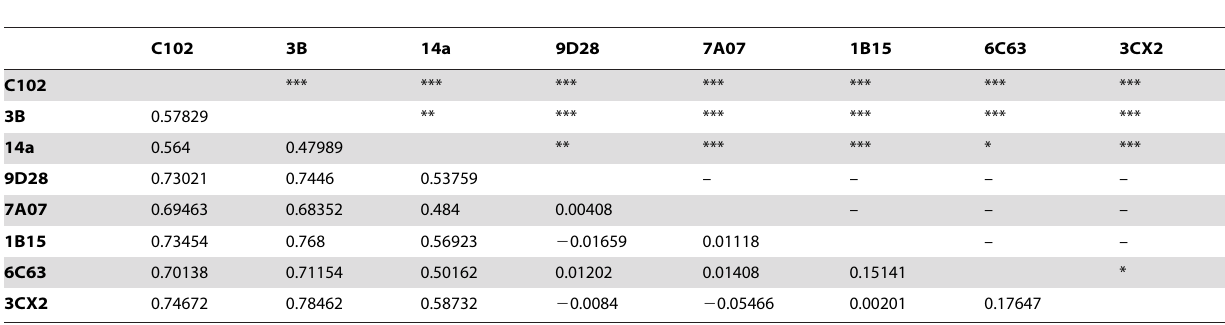
Table 6. Pairwise Fst Values between populations of the quill worm, Hyalinoecia longibranchiata, using a fragment of the 16S